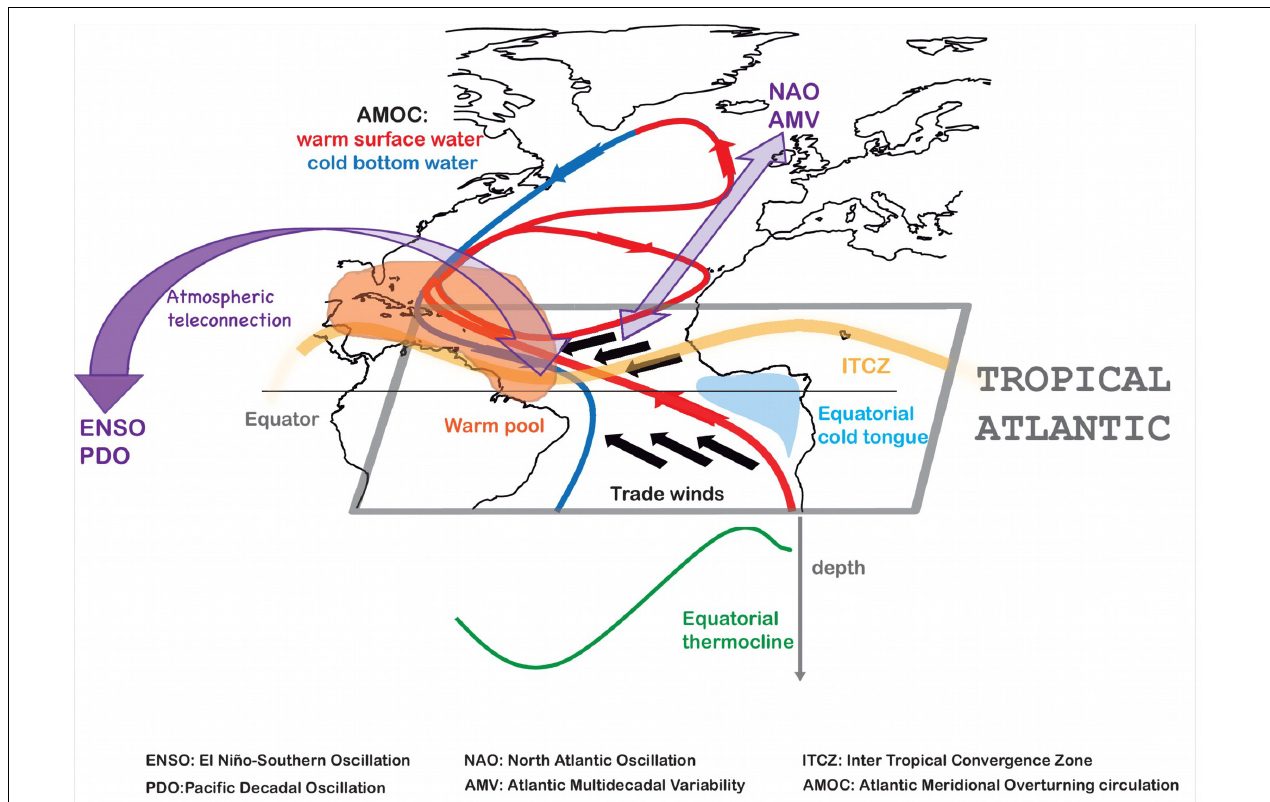
FIGURE 3 | Schematic of the key components for understanding tropical Atlantic